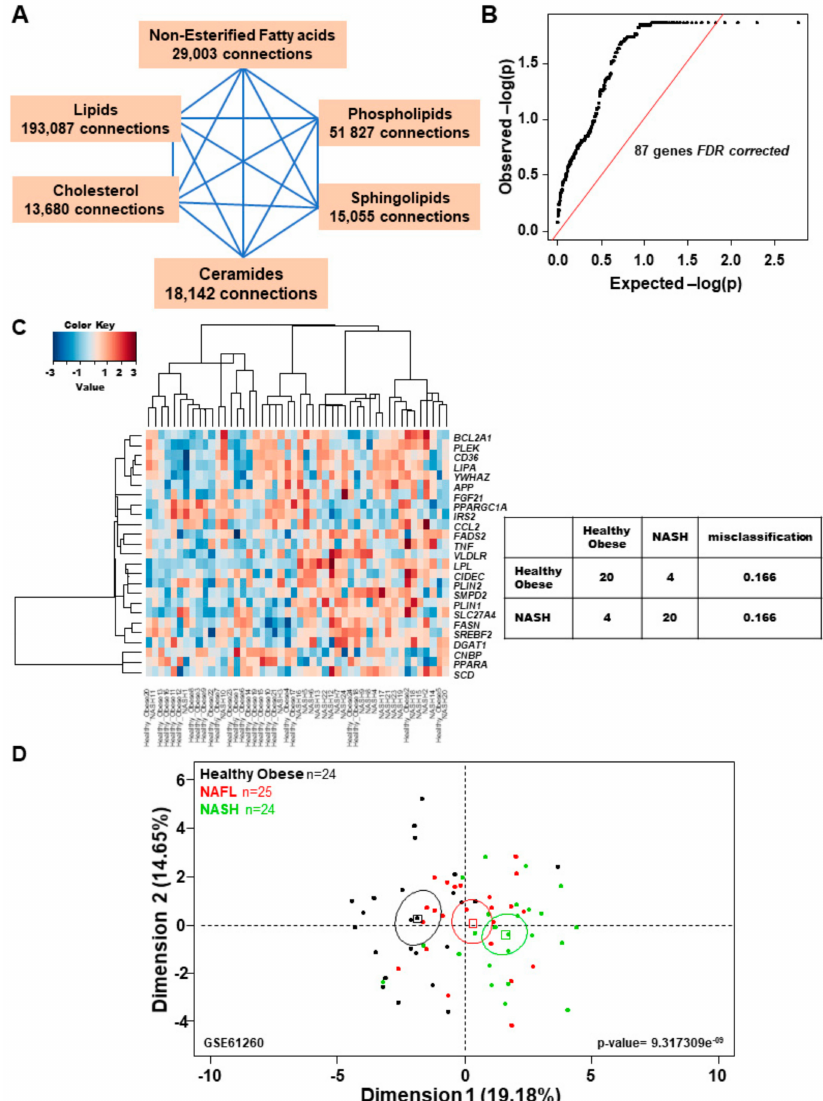
Figure 2. Lipid-related genes di ff erentially expressed between NASH and healthy obese liver samples. ( A ) Text-mining summary of connections observed between genes and lipid terms, number of gene co-occurrence of gene symbol with language terms in scientific literature. ( B ) qqplot of q -values obtained by false discovery rate correction of text-mining results (87 genes are still significant after correction, q -values < 0.05). ( C ) Expression heatmap of lipid related genes found di ff erential expressed between NASH liver samples ( n = 24) and Healthy obese liver samples ( n = 24) in transcriptome dataset GSE21260 ( D ) unsupervised principal component analysis performed with lipid related genes found di ff erentially expressed between NASH and Healthy obese in GSE21260 and impact of their prediction to predicted NAFL samples ( n = 23), p-value was calculated by correlation of sample group discrimination on first principal